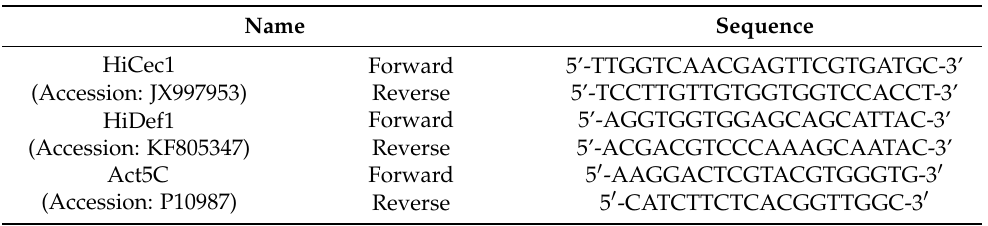
Table 1. Primer sequences used to analyze HiCec1 ( Hermetia illucens cecropin1) and HiDef1 ( H. illucens defensin1) gene expressions using real-time